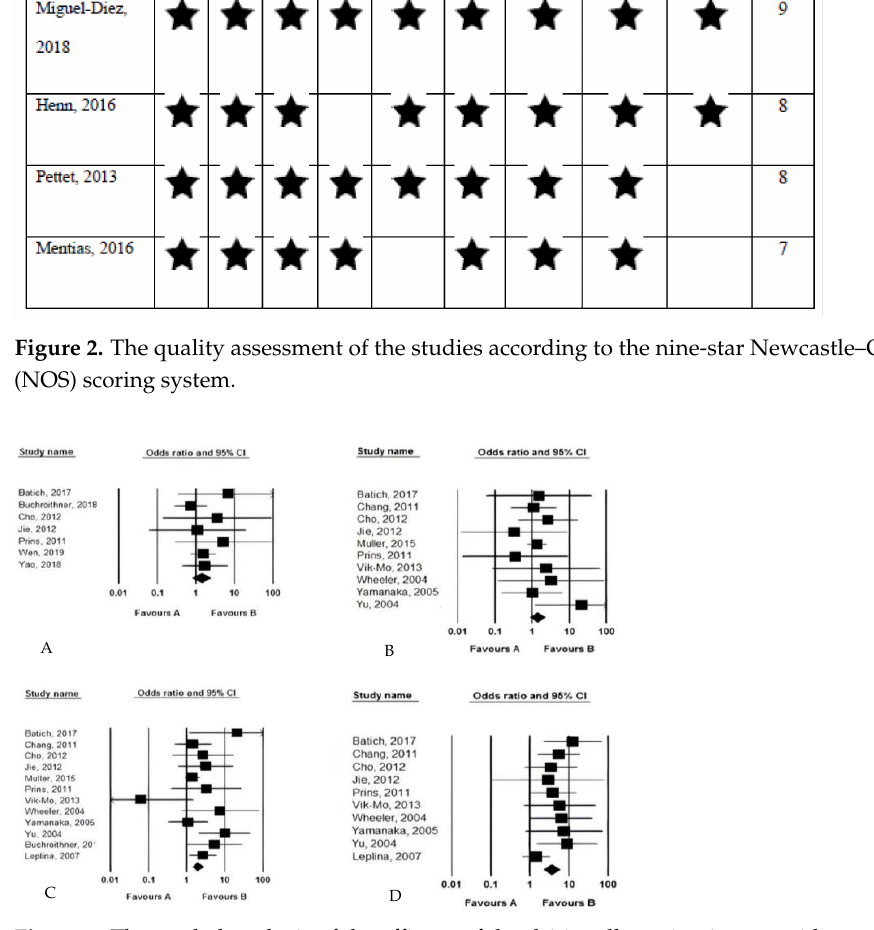
Figure 3. The pooled analysis of the efficacy of dendritic cell vaccination on mid-term survival (A: 6-month PFS, B: 6-month OS, C: 12-month OS, D: 24-month OS). Safety outcomes: No side effects were reported following DCV protocols, and drug- related complications were tolerable and reversible (Table 2). Table 2. The outcome of the dendritic cell vaccination strategy.